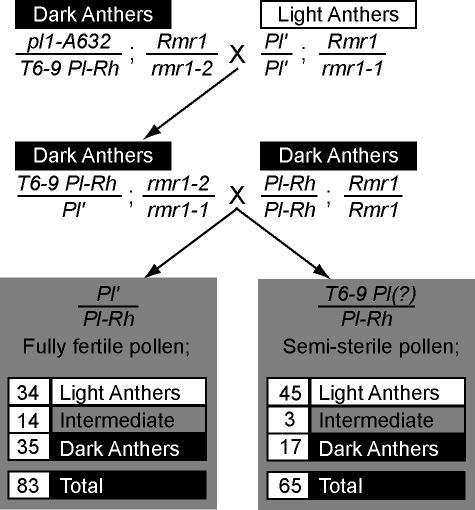

Pl′ Establishment in an rmr1 Mutant BackgroundPlants with a T6–9 translocation chromosome carrying Pl1-Rhoades in the Pl-Rh state (dark anther pigmentation) and heterozygous for the rmr1–2 allele were crossed to Pl′ plants (light anther pigmentation) heterozygous for the rmr1–1 allele. Of the resultant progeny with semi-sterile pollen (heterozygous for the T6–9 interchange pair), plants homozygous for a mutation at rmr1 were chosen based on the dark anther phenotype. These plants were then crossed to a Pl-Rh tester with the expectation that in progeny inheriting the interchange, the expression status of the Pl1-Rhoades allele on the T6–9 translocation chromosome (T6–9 Pl(?)) would indicate if establishment of the Pl′ state was affected in the F1. The numbers represent the number of plants displaying a given anther phenotype, indicating that the Pl′ state was established on the interchange chromosome in the rmr1 mutants.